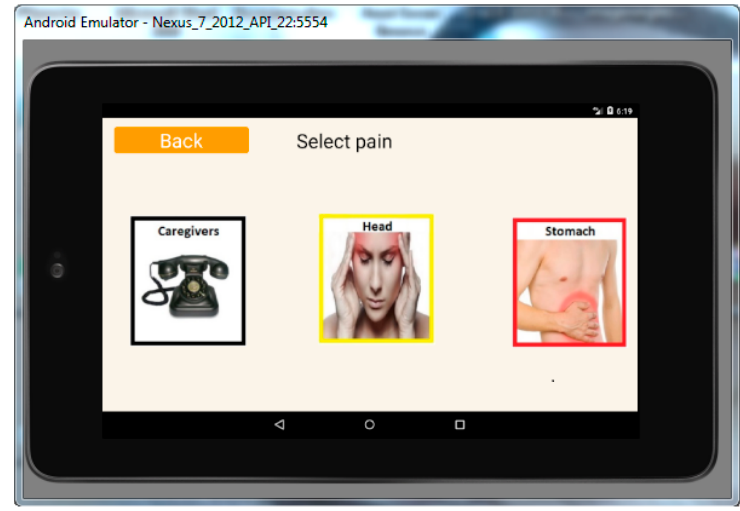
Figure 1. Screenshot of the Telecare system generated from the